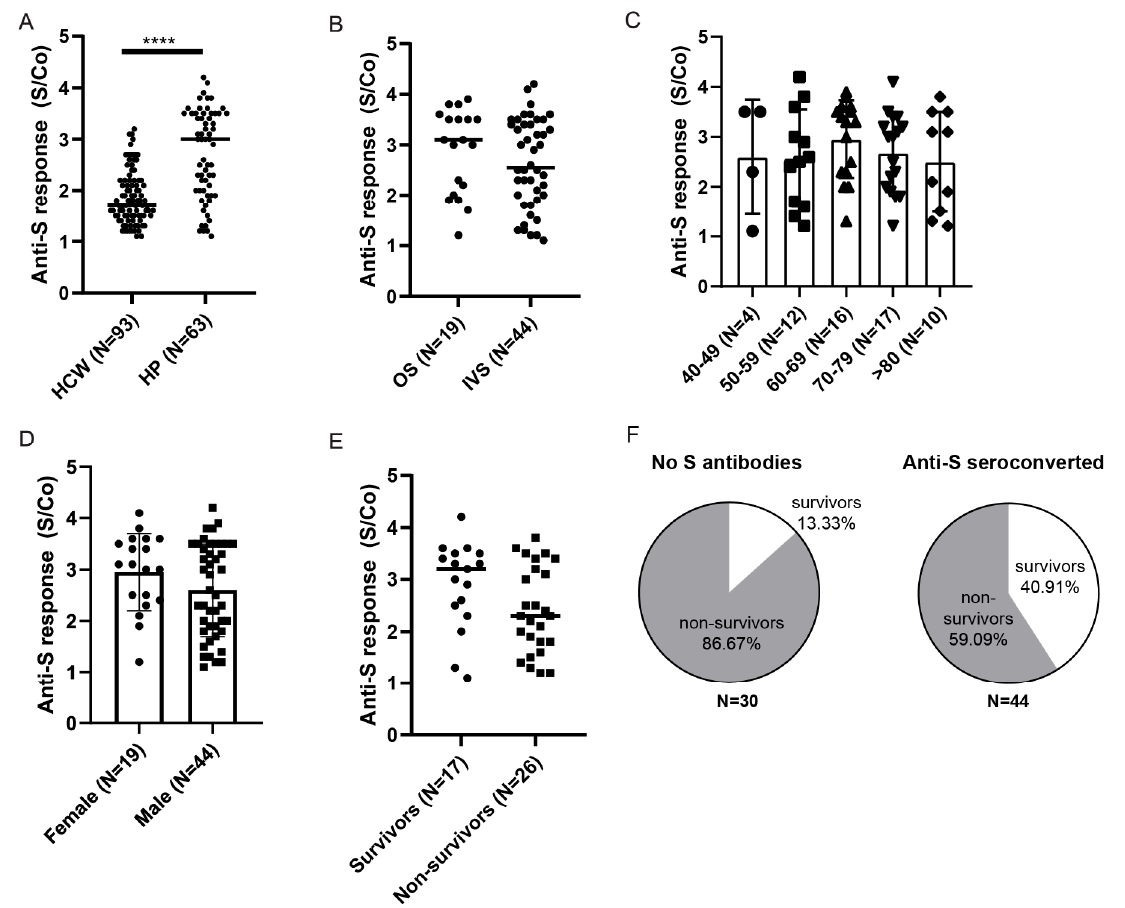
Figure 6. Anti-Spike antibody response in HPs. ( A ) Comparison of anti-Spike antibody levels between in hospitalized patients (HP) and healthcare workers (HCW) identified prior to vaccination. ( B ) Hospitalized seroconverted patients were stratified based on the severity of the disease: oxygen supplementation (OS) vs. invasive ventilation support (IVS), ( C ) age, ( D ) gender, or ( E ) mortality outcome for non-vaccinated patients on invasive ventilation support. ( F ) Frequencies of survivors and non-survivors in relation to anti-Spike seroconversion in IVS cohort. S/Co, Signal to cut-off ratio. Statistical tests: unpaired t -test ( A ), p value **** p < 0.0001.